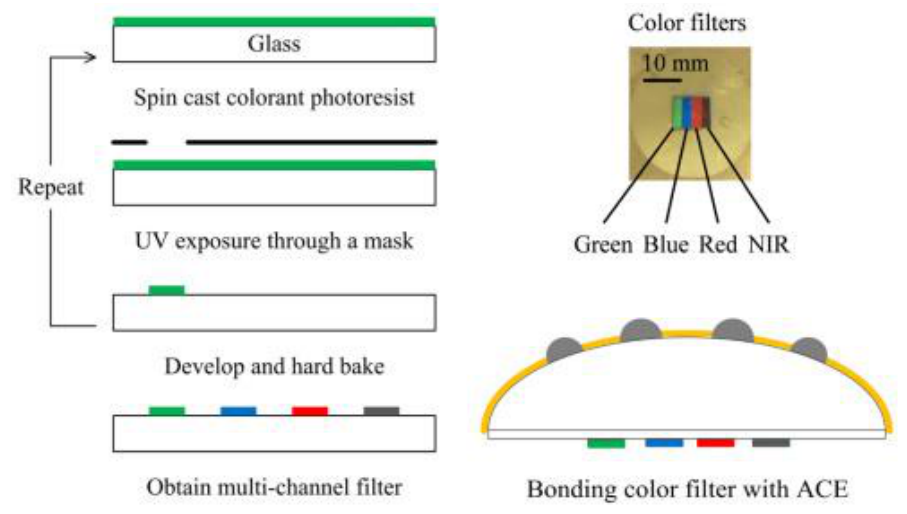
Figure 43. Illustration of the repeated lithographic processes for fabricating the multi-channel filters